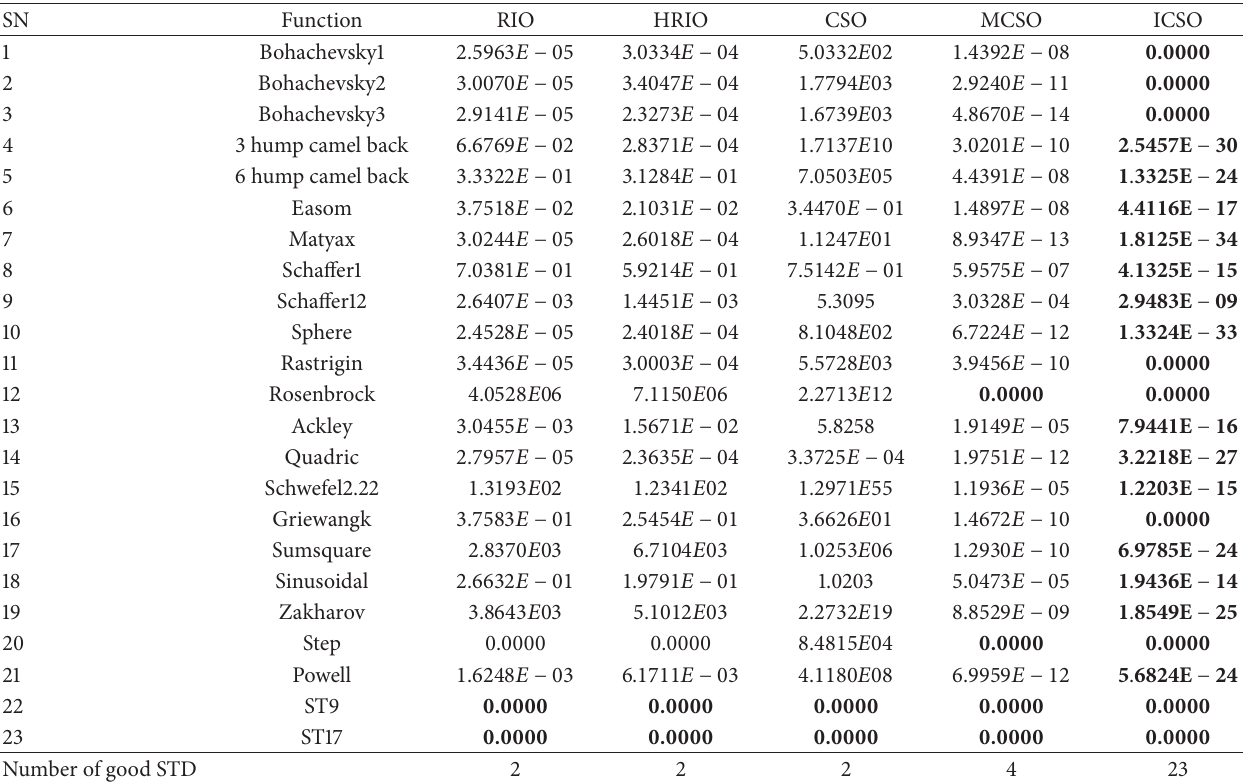
Table 7: Comparison of standard deviation of mean global optimum values of RIO, HRIO, CSO, MCSO, and ICSO.